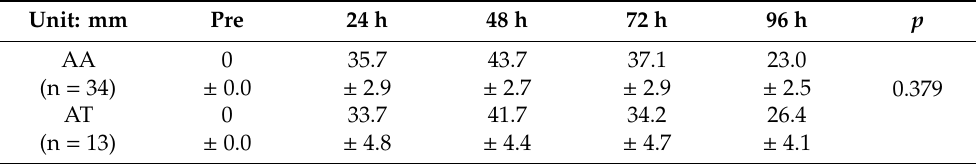
Table 3. Changes in muscle soreness after eccentric exercise according to the myostatin A55T genotype. Unit: